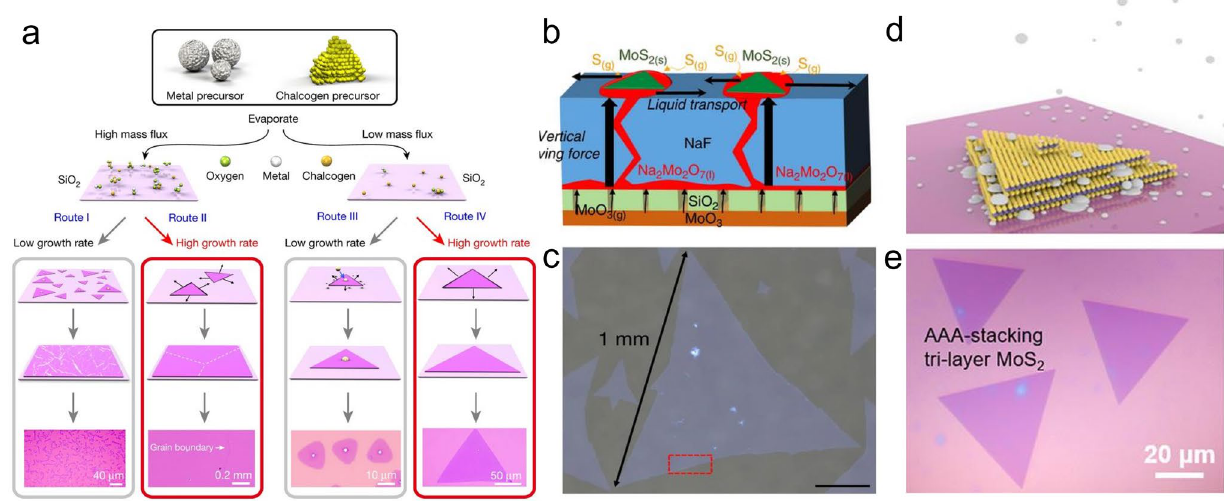
Fig. 7 Catalytic growth of TMDCs by alkali metal halides. a Catalytic mechanism [100], Copyright 2018, Springer Nature. b , c The realization growth of 1 mm-size